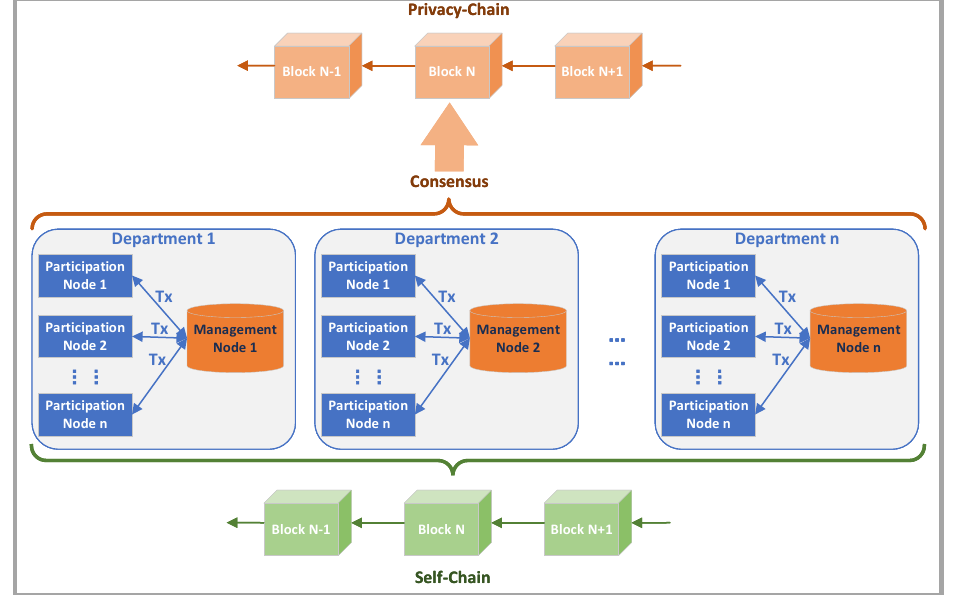
Figure 2. Schematic diagram of the system